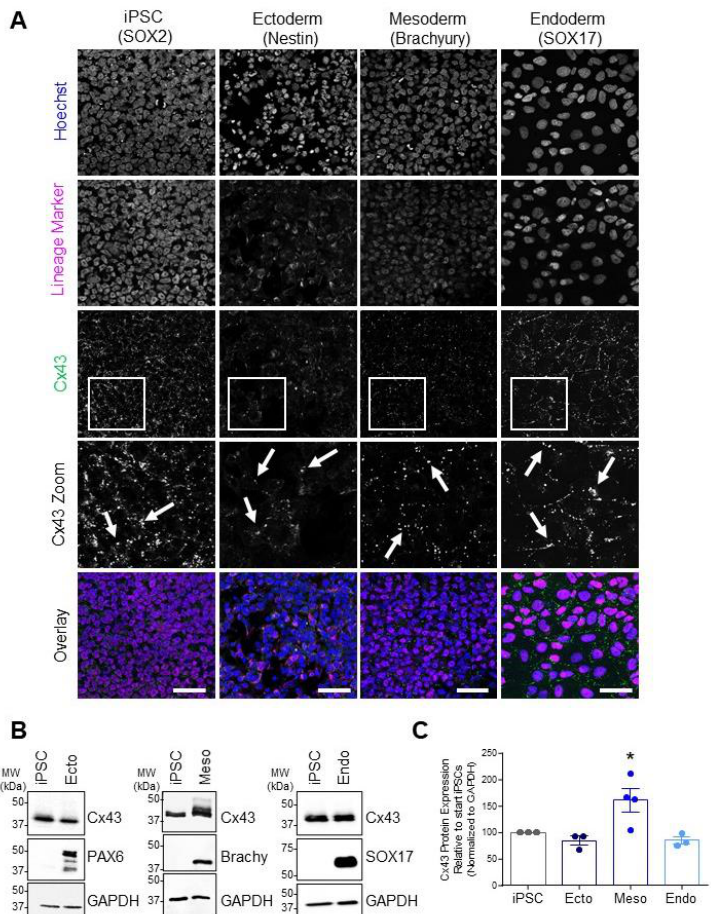
Figure 2. Cx43 protein expression and localization in iPSCs and cells of each germ lineage. ( A ) Representative immunofluorescent confocal micrographs, demonstrating Cx43 (green) localization in control iPSCs (SOX2, iPSCs: purple) and after directed differentiation toward the three germ lineages (Nestin, ectoderm; Brachyury, mesoderm; SOX17, endoderm: purple) and nuclei (Hoechst, nuclei: blue). Cx43 forms large puncta (white arrows) at the cell surface indicative of gap junction plaques. Scale bars = 50 µm. ( B ) Representative Western blots and ( C ) densitometric analysis of total Cx43 protein expression in PAX6-positive ectoderm, Brachyury-positive mesoderm, and SOX17-positive endoderm cells. * p < 0.05 compared to undifferentiated iPSCs. Data represent the standard error of the mean of 3 – 4 independent experiments.